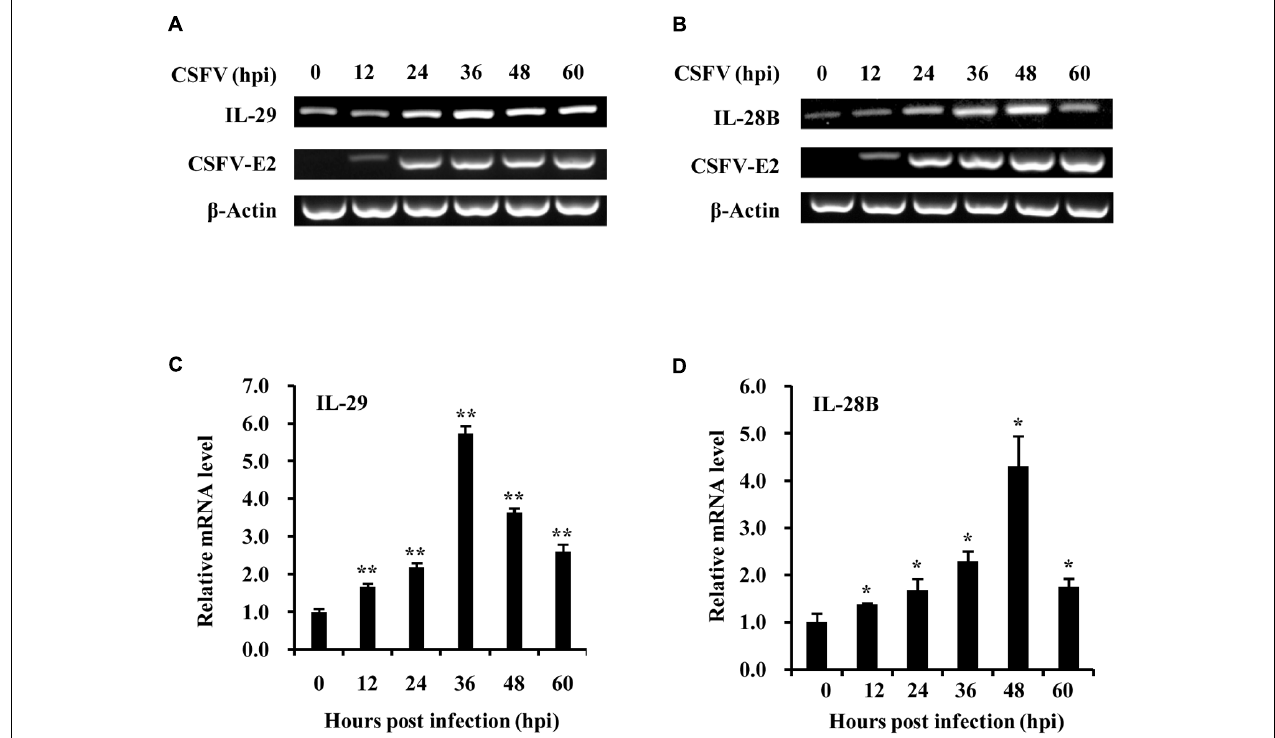
FIGURE 1 | Classical swine fever virus (CSFV) infection induces the expression of type III IFNs in PK-15 cells. (A,B) PK-15 cells were infected with or without CSFV Shimen strain and harvested at the indicated time. RT-PCR analysis was performed to determine the expression of CSFV structural protein gene E2, IL-29 (A) and IL-28B (B) . The CSFV E2 was used to indicate the virus infection and replication. Quantitative real-time PCR was further performed to examine the mRNA levels of Type III IFNs, IL-29 (C) and IL-28B (D) in PK-15 cells infected with CSFV for indicated time. Plotted are the average results from three independent experiments. ∗ P < 0.05, ∗∗ P <